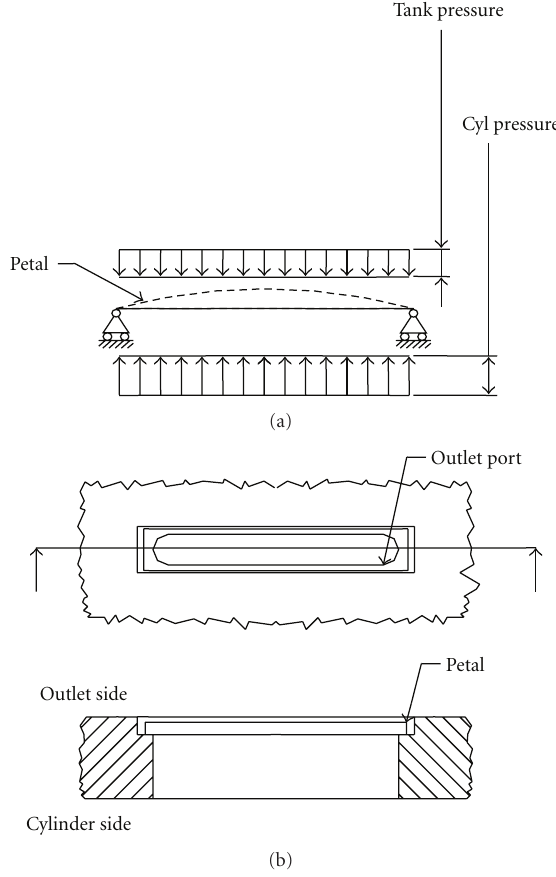
Figure 2: (a) Reed valve deflection, (b) outlet valve.